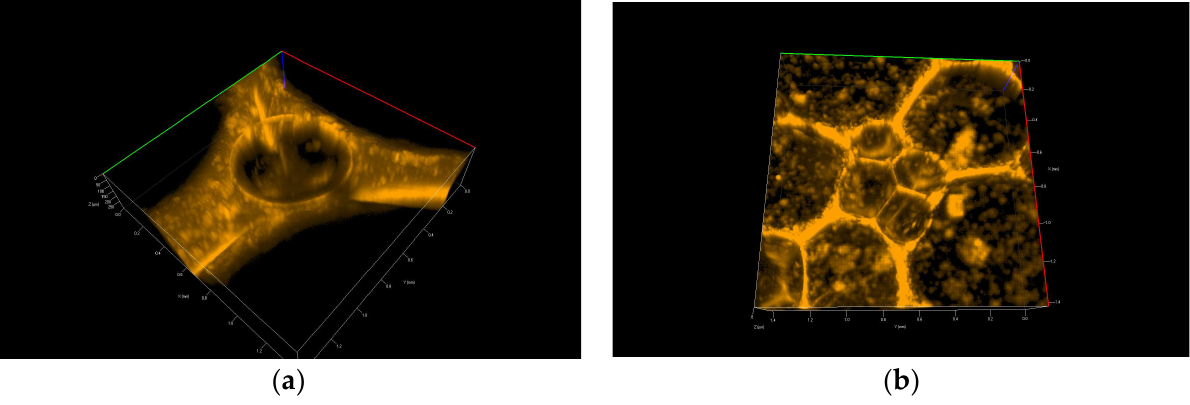
Figure 7. Confocal microscopy photo of 3D foams generated from the chitosan—LAE— Levasil®mixtures: Levasil®500/15% 6 nm ( a ) and Levasil®300/30% 9 nm ( b